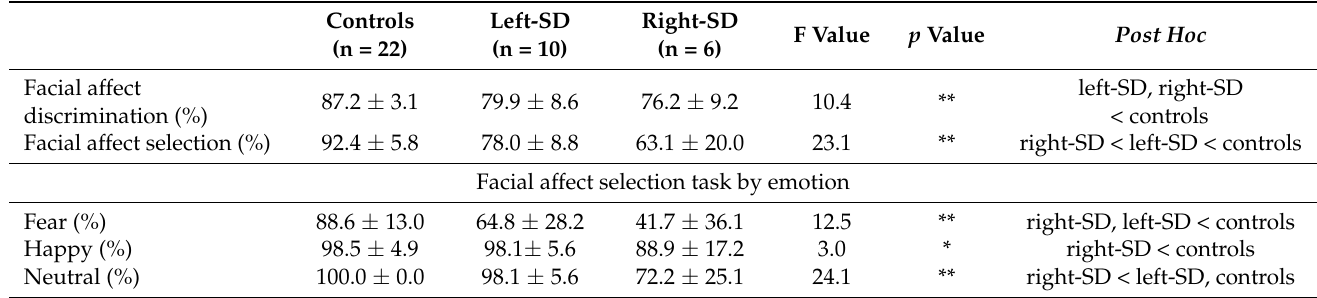
Table 2. Performance on facial affect tasks in semantic dementia patients and